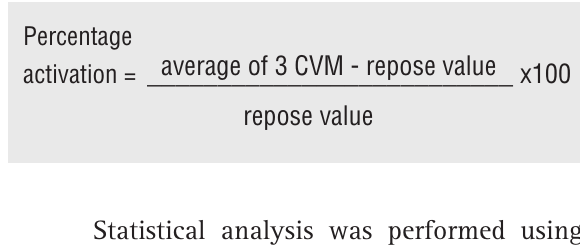
figure 2 - Calculus of percentage of variation in relation to rest.